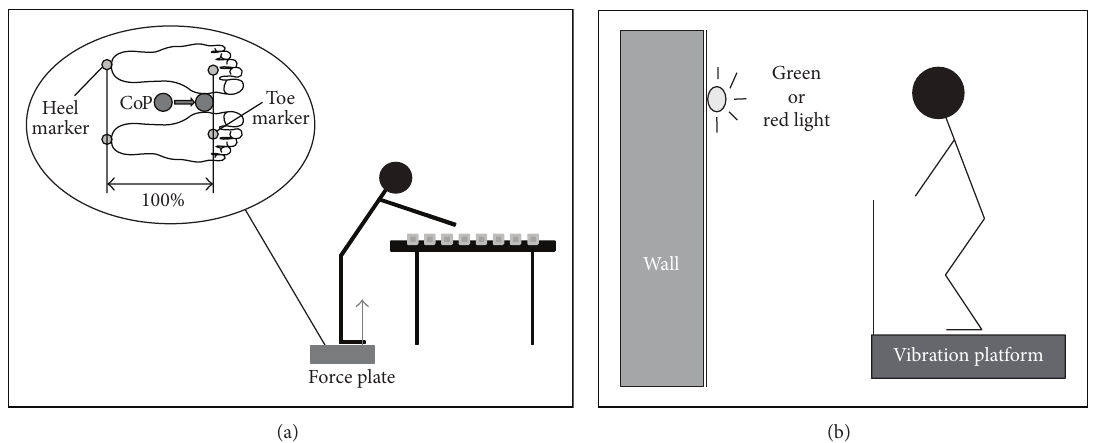
Figure 2: (a) Visualization of the Functional Reach Test (FRT) and calculation of the Center of Pressure (CoP) to the normalized foot length in %. The horizontal distance between heel marker and toe marker was defined as 100%. (b) Test set-up for the intervention. Both groups stood on the vibration platform with knees slightly bend. The placebo group had additionally to concentrate on the light on the wall.